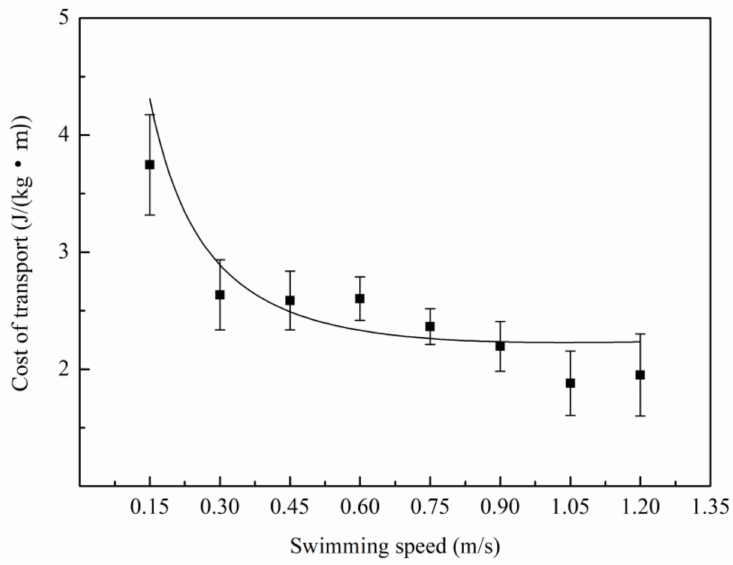
Figure 5. Cost of transport ( COT , mean ± SEM) as a function of swimming speed (function: COT = 0.49 U s − 1 + 1.73 U s 0.27 , R 2 = 0.594, p < 0.001).